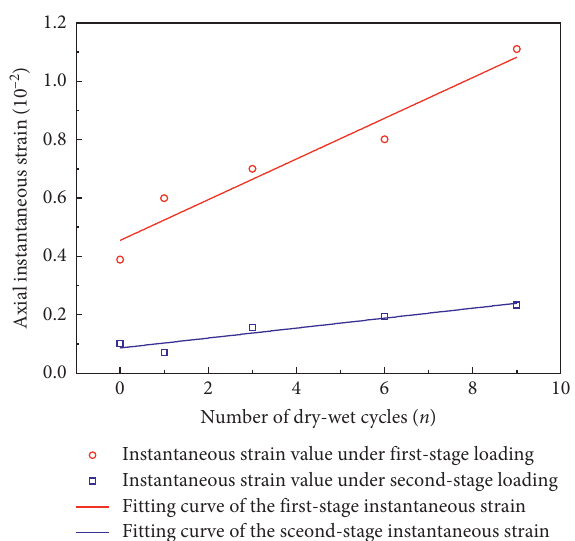
Figure 13: The instantaneous strain curves at the different loading levels of the specimens.